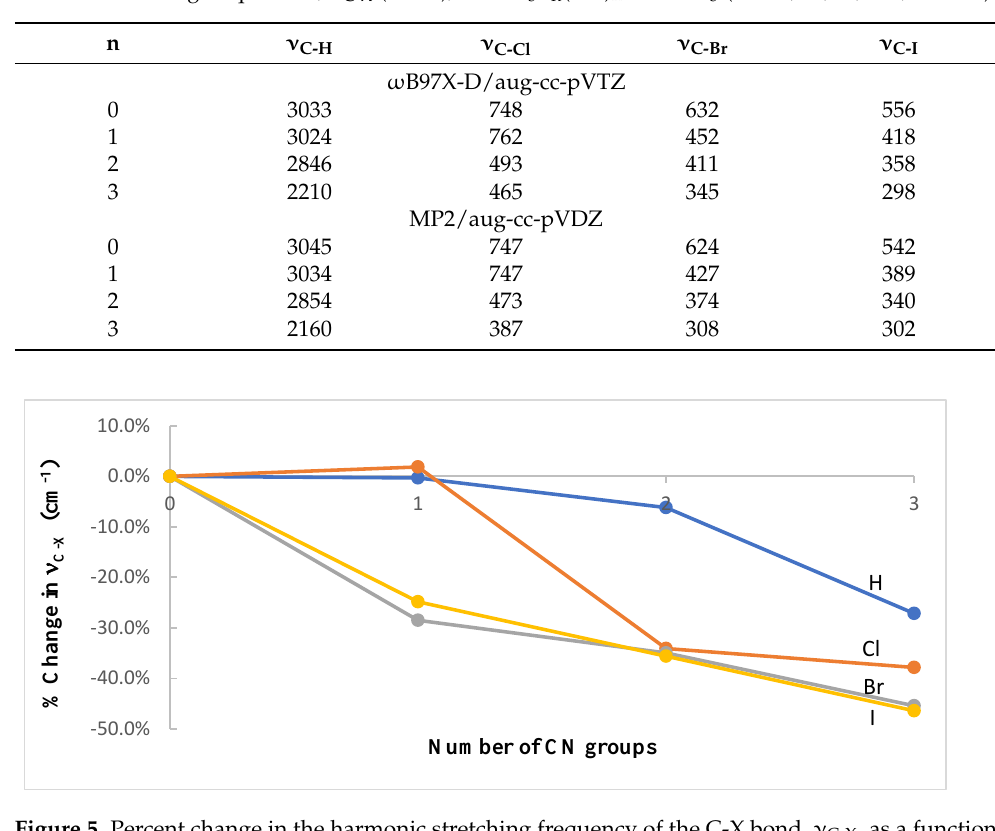
of the number of CN groups in the CH 3 − n (CN) n X ··· NMe 3 (X = H, Cl, Br, or I; n = 0–3) complexes